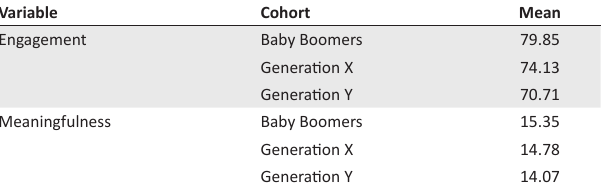
TABLE 5: Estimated marginal